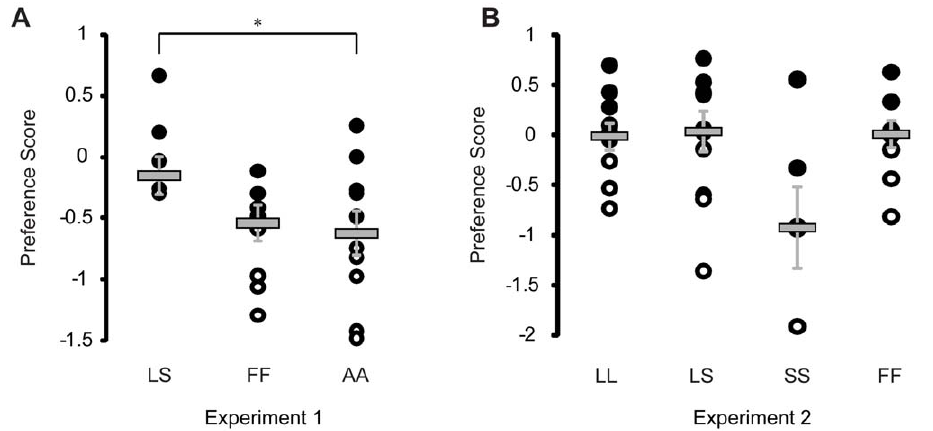
Figure 1. Female preference behavior. Behavioral preference scores for each individual in (a) Experiment 1 ( egr-1 quantification) and (b) Experiment 2 ( neuroserpin quantification) by treatment context. Gray horizontal line is the median with standard error. Black and white circles represent high ( . median) and low ( , median) preference score females, respectively. *, p , 0.01.